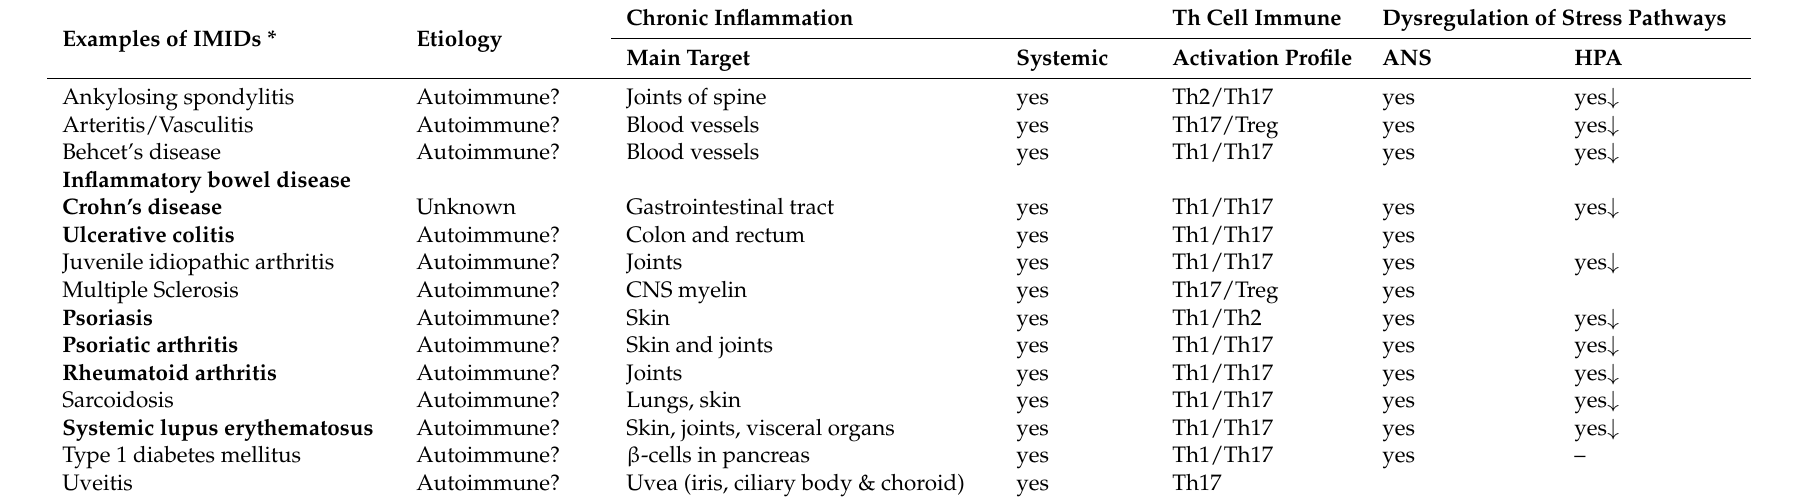
Table 1. Examples of IMIDs, their Etiology and Neural-Immune